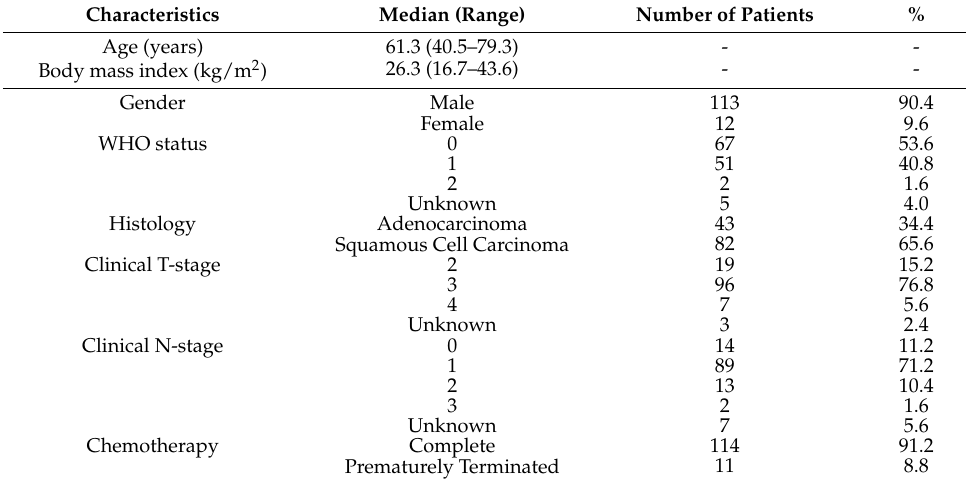
Table 1. Characteristics of patient cohort ( n = 125).